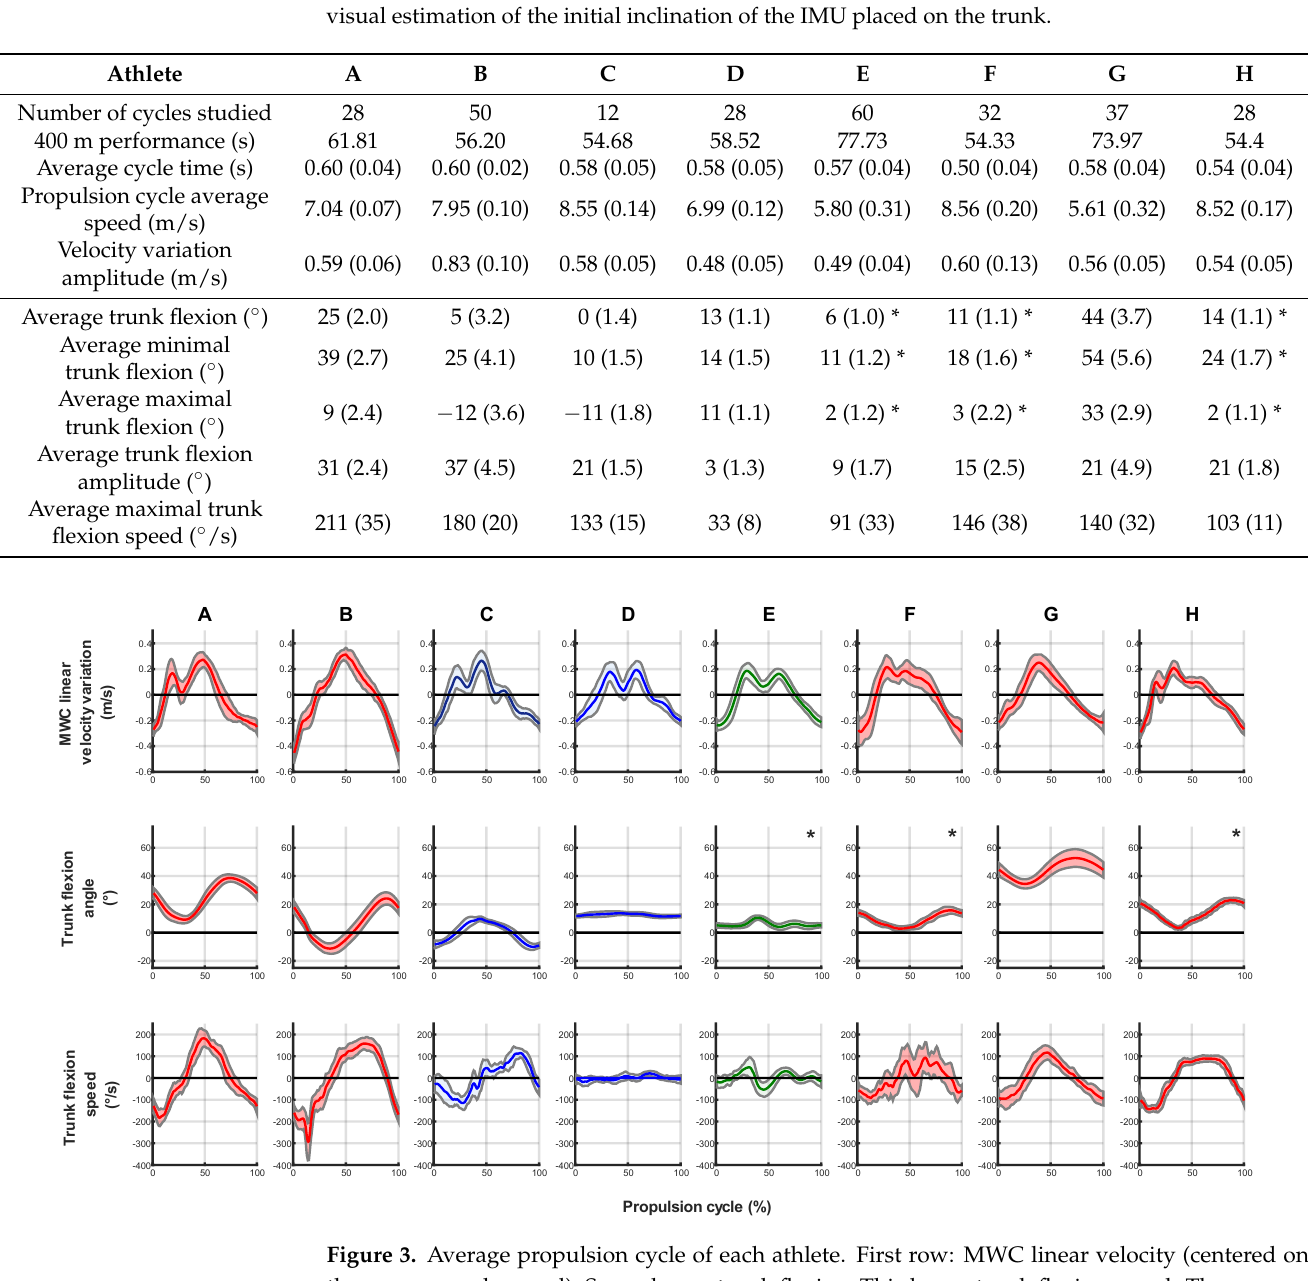
Table 2. Number of cycles studied per athlete, time to perform 400m, average propulsion parameters (cycle time, propulsion cycle speed and absolute linear velocity variation) and average trunk kine- matics. Standard deviations are presented in parenthesis. *: data with a potential offset due to the visual estimation of the initial inclination of the IMU placed on the trunk.